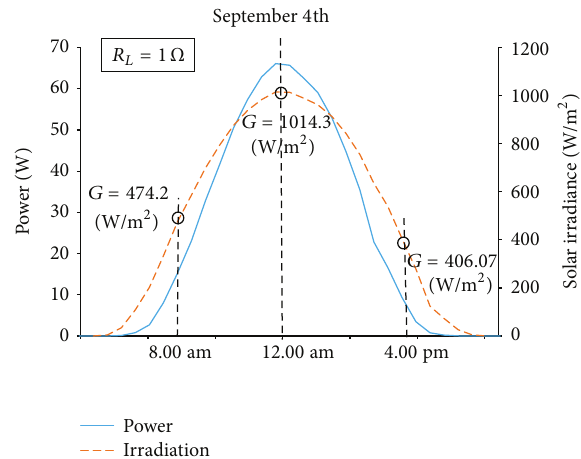
Figure 4: Power production of a PV panel with an electrical load 𝑅 𝐿 = 1 Ω .